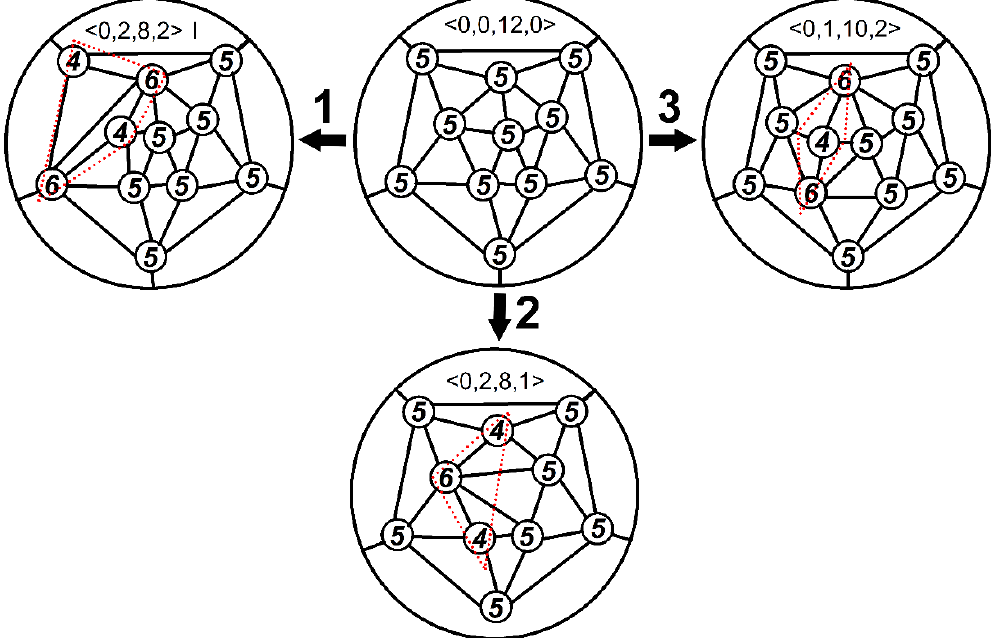
Figure 3. Planar projections of the full icosahedral cluster <0,0,12,0> and three corresponding clusters transformed from <0,0,12,0>.